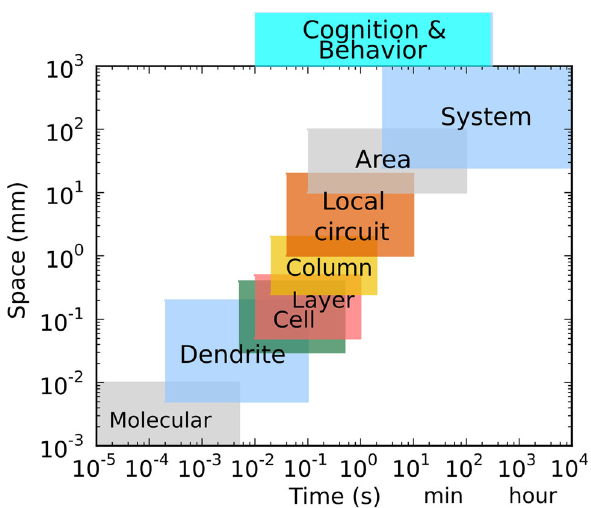
Fig. 1 Temporal and spatial scales of organization in the nervous system. The proper spatial scale of ‘‘Cognition and Behavior’’ depends on how it is being viewed and modeled. Scale overlap can be seen by noting that dendrite, cell and column share scale in both time and space, reflecting the fact that the same neural signals are being processed at these different